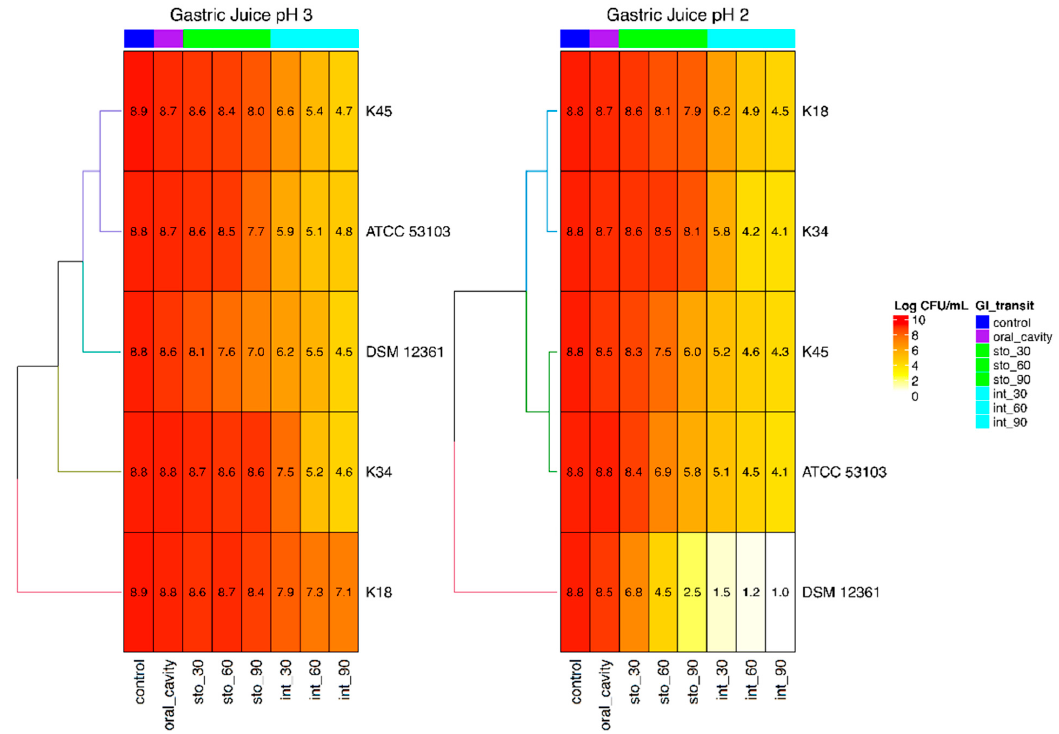
Figure 1. Heat maps depicting bacterial viability of A. kunkeei K18, K34, K45 and DSM 12361 and L. rhamnosus GG ATCC 53103 in simulated gastrointestinal conditions.